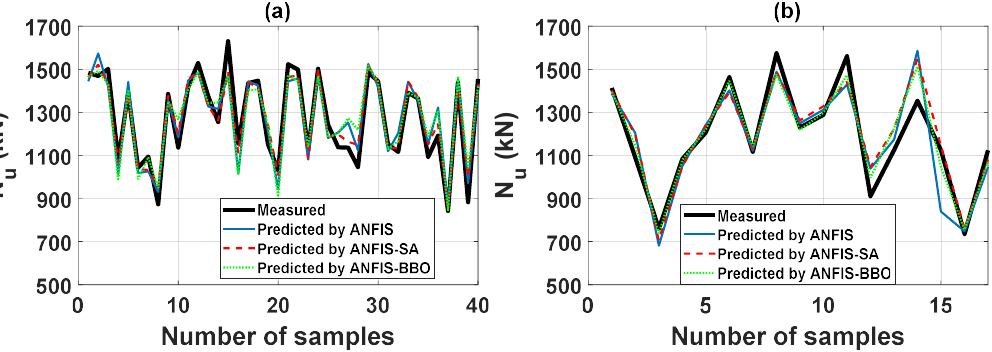
Appl. Sci. 2019 , 9 , x FOR PEER REVIEW Figure 6. Graphs of N u in function of sample index for ( a ) the training part and ( b ) the testing part.